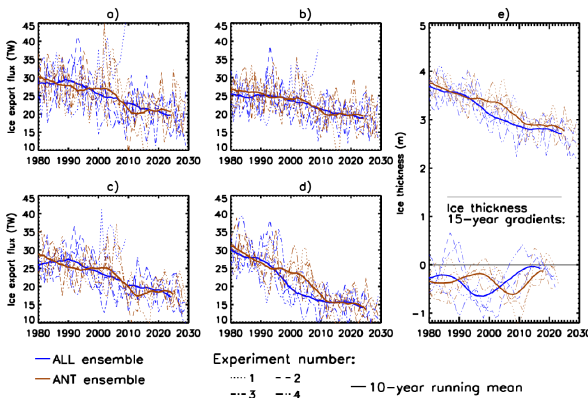
Fig. 6. Ice export from the Arctic Ocean in the HadGEM1 runs. Showing (a) exact ice export as calculated in the heat budget; (b) ice export through the Fram Strait, calculated as ∫ h ice v ice · d S ; (c) ice export calculated as in (b) , but with the time-varying v ice fields re- placed by their time mean; (d) ice export calculated as in (c) , but with the h ice fields replaced by their time mean, plus the time series of anomalies of ice thickness in the western Arctic region as defined in Fig. 4. (e) shows mean ice thickness in the western Arctic region, with 15-yr running